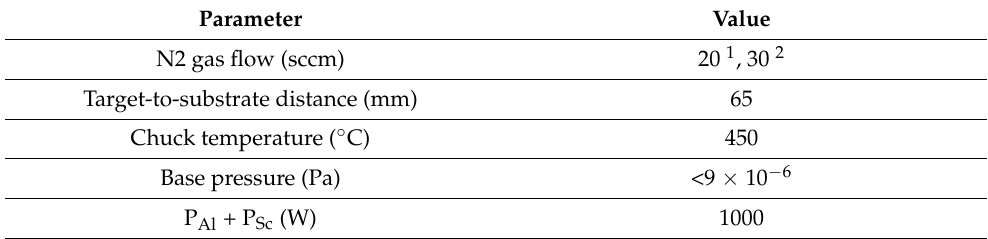
Table 1. Growth parameters of Al 0.77 Sc 0.23 N.